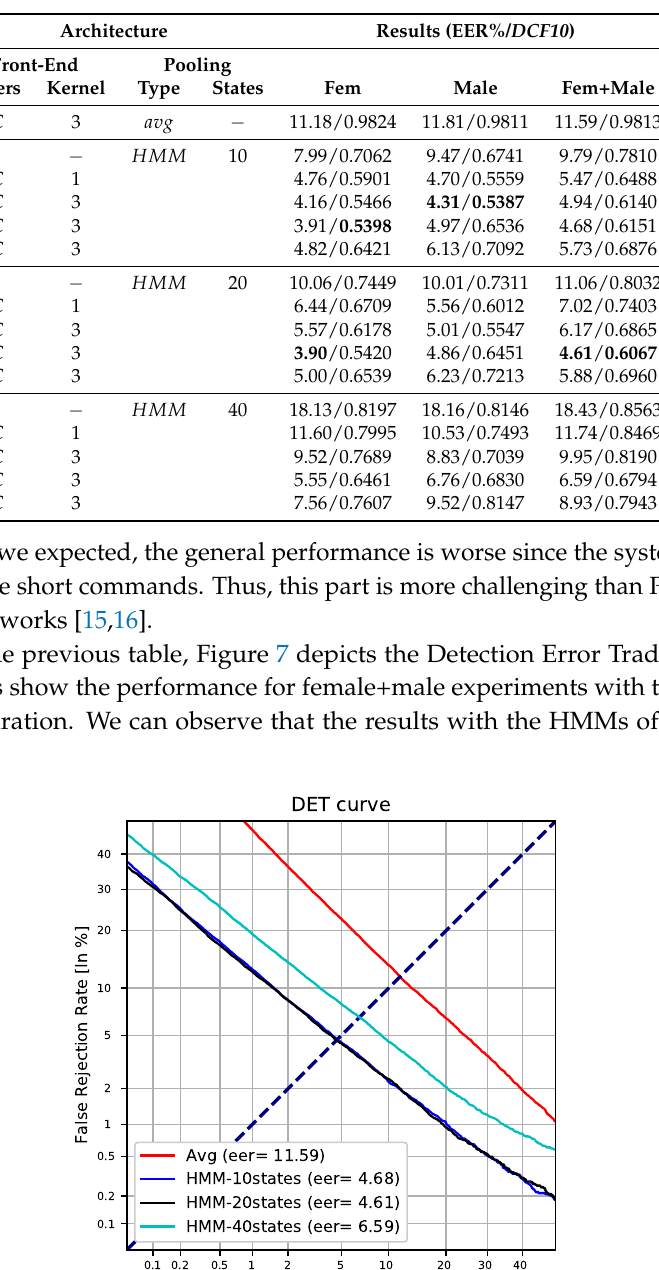
Table 3. Experimental results on RSR2015-Part II [22] eval set, showing EER% and NIST 2010 min cost ( DCF10 ). These results were obtained by training with bkg+dev subsets and by varying the number of states of the HMM. The best results are marked in bold.